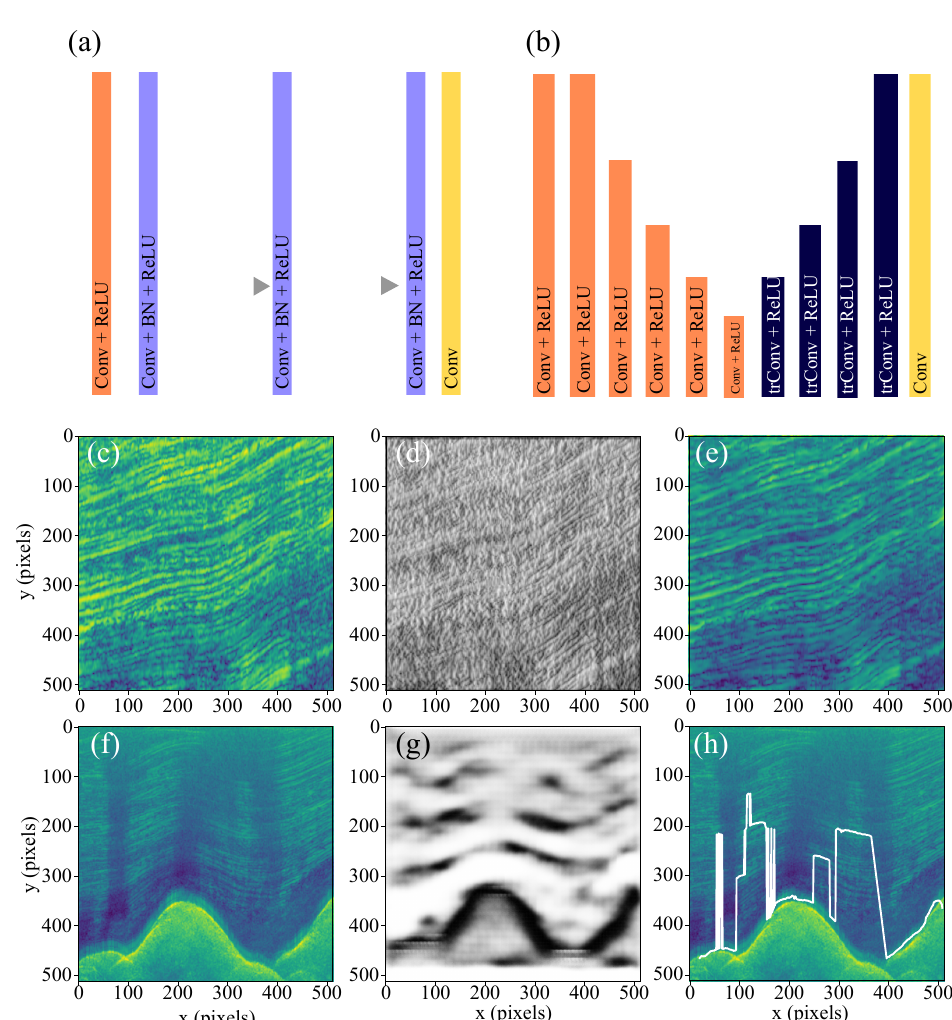
Figure 5. Structures of the DnCNN and U-Net that are applied in denoising and extraction and a demonstration of the denoise and bedrock interface extraction. ( a ) The network structure of the DnCNN for imagery denoising, in which the dash vectors present the data flow. ( b ) The network structure of U-Net for feature extraction, in which the gray dashed line presents the skip connections between layers. ( c ) The input radar image from R3 slices of Line 1 (Figure 2) for validation of DnCNN denoising. ( d ) The extracted noise from the input radar image. ( e ) The denoised result of radar image slices. (f ) The input radar image from the R1 slices of Line 1 (Figure 2) for U-Net extraction. ( g ) The distribution of extracted bedrock interface features. ( h ) Comparison between the input radar image and the extracted